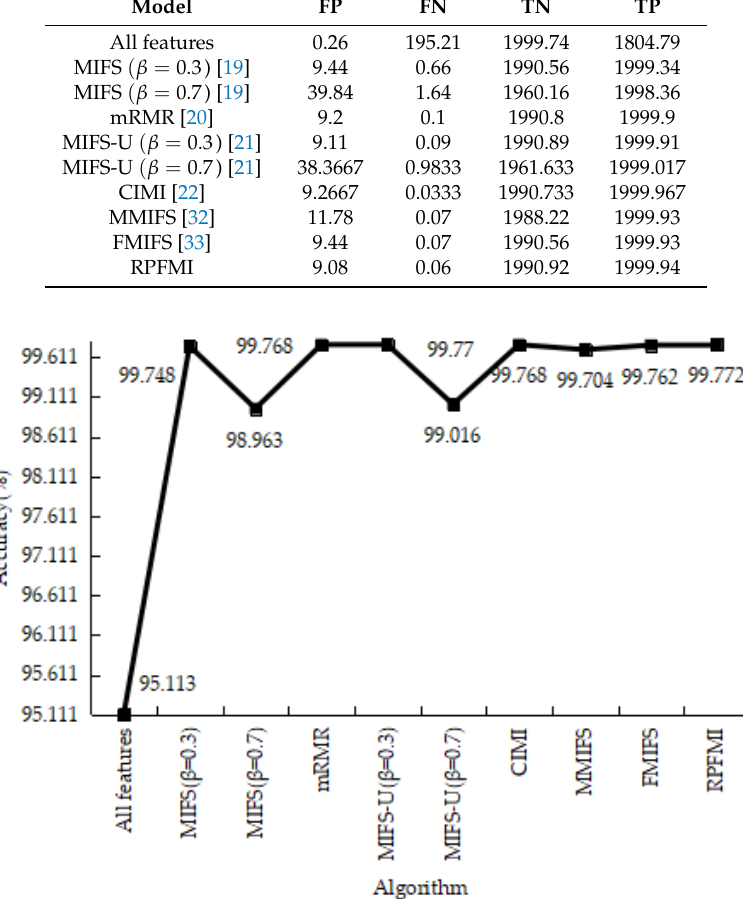
Figure 2. Detection Rate on the DOS test data. 90.24